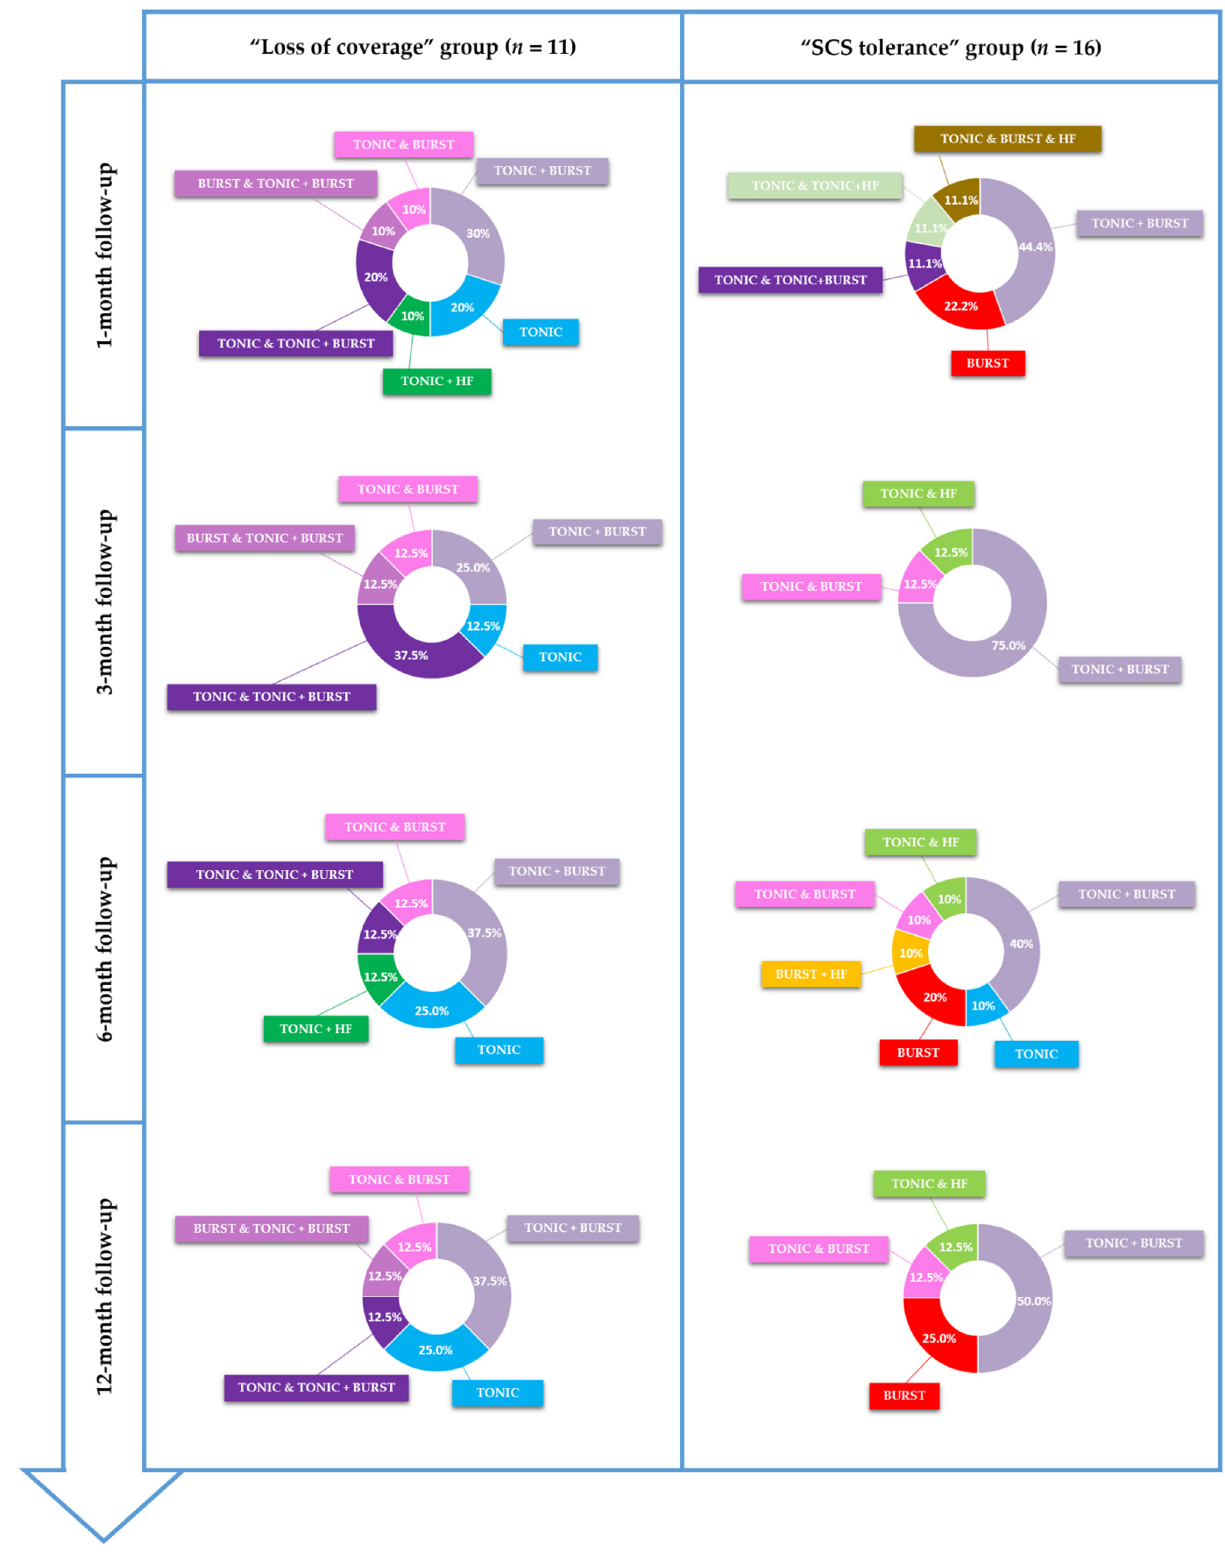
Figure 4. Pie chart of the waveforms used by the “loss of coverage” and “SCS tolerance” groups for each follow-up. The sign “+” represents combination therapies (i.e., when two waveforms are used simultaneously) and the sign “&” represents programs that are used separately (e.g., TONIC & HF might be TONIC during the day and HF during night).